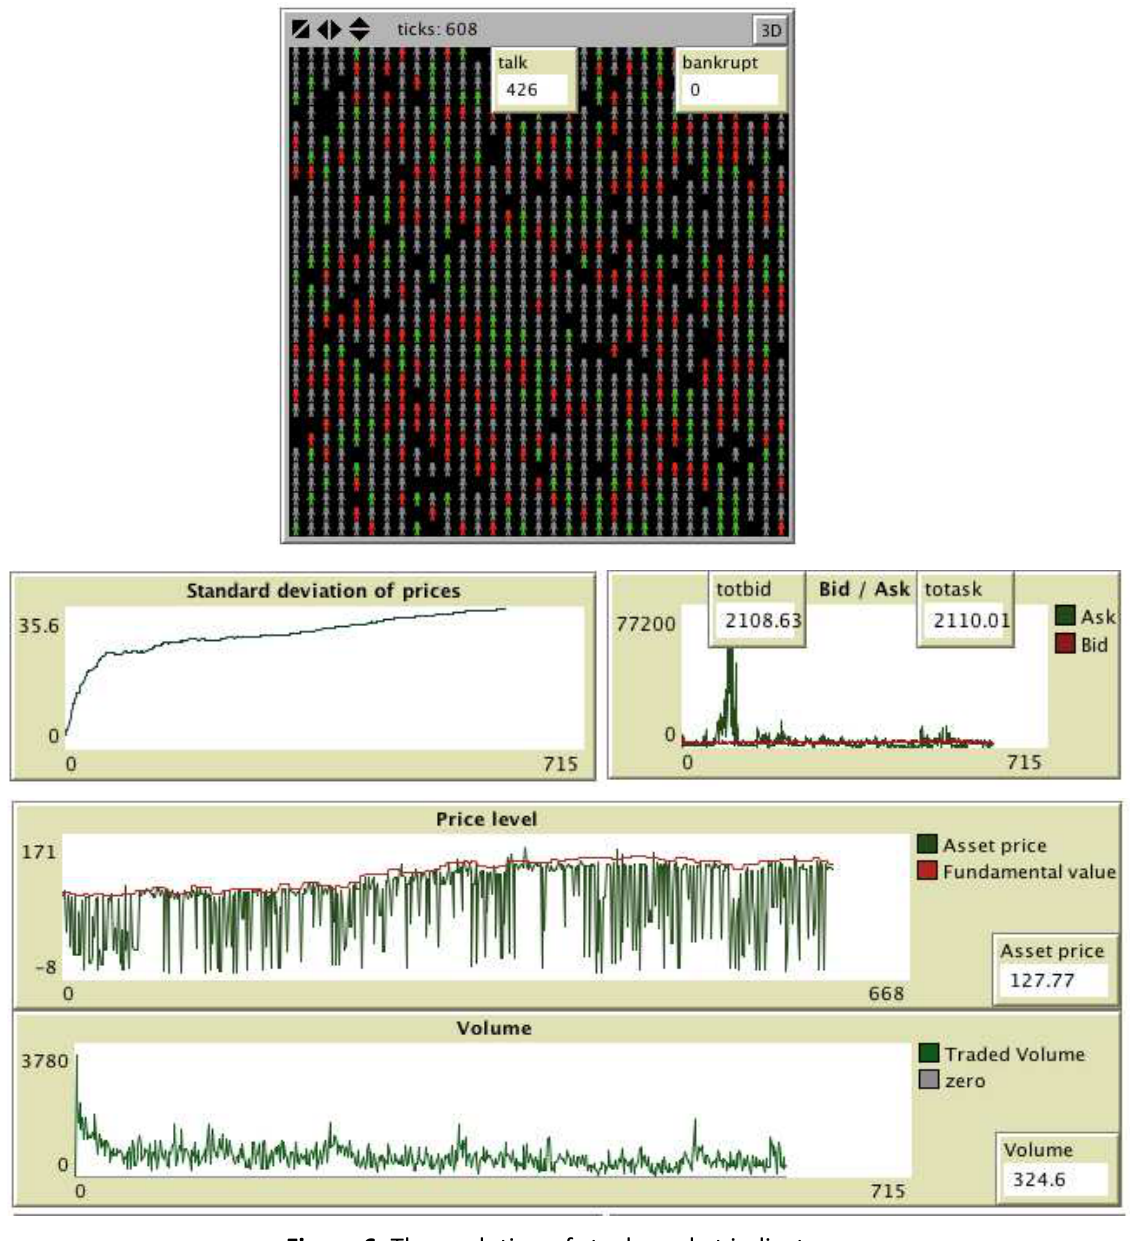
Figure 6. The evolution of stock market indicators (volatility, volume, price level, bankruptcy) in the case